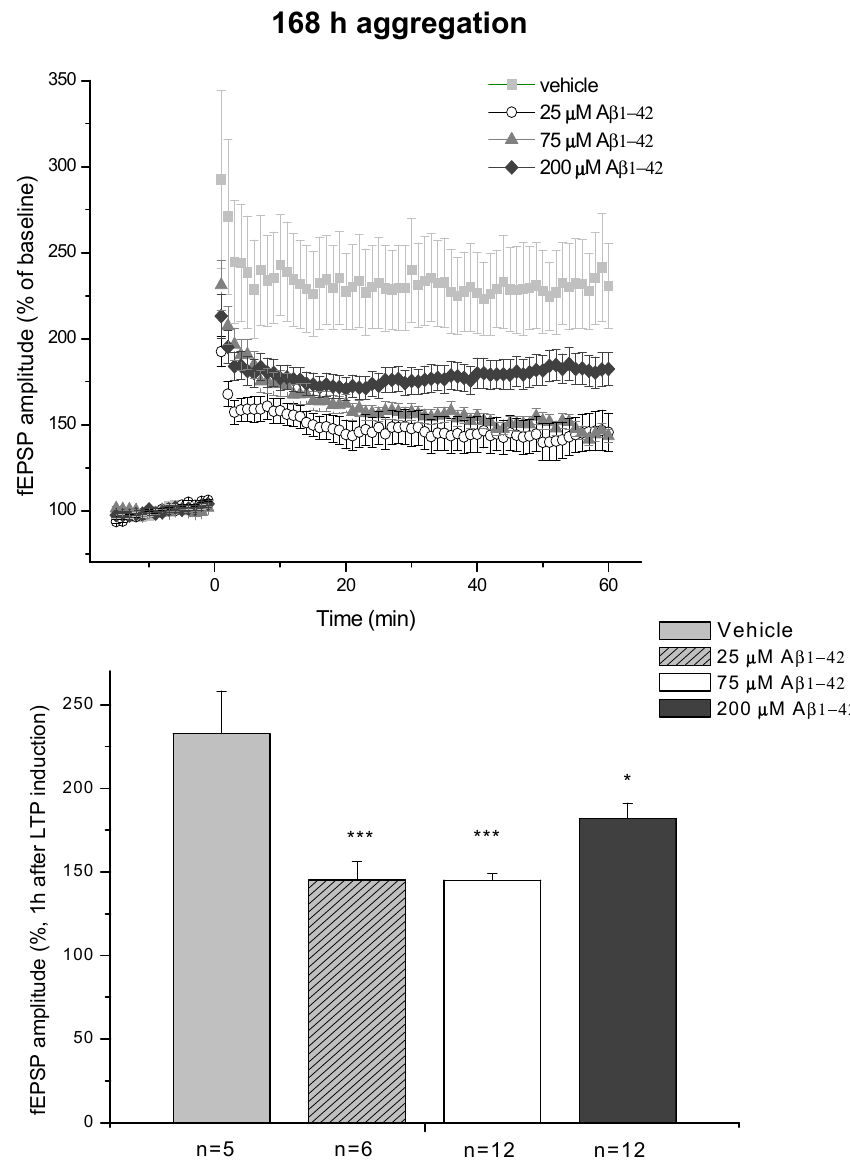
Figure 18. LTP impairment depends on the aggregation concentration of A β 1-42. The effect of 168/25 µ M, 168 h/75 µ M and 168/200 µ M oA β 1-42 samples in acute HC slices. The histogram shows the level of fEPSP potentiation between 55 and 60 min post-TBS. Error bars represent ± SEM. * p ≤ 0.05 and *** p ≤ 0.001.